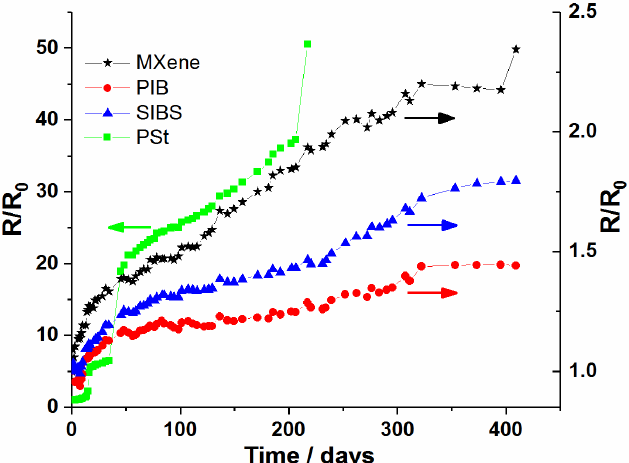
Figure 6. Temporal evolution of the relative electrical resistance R/R 0 (R 0 —initial resistance values, R—monitored resistance values) for uncoated and polymer-coated MXene films stored under ambient conditions .